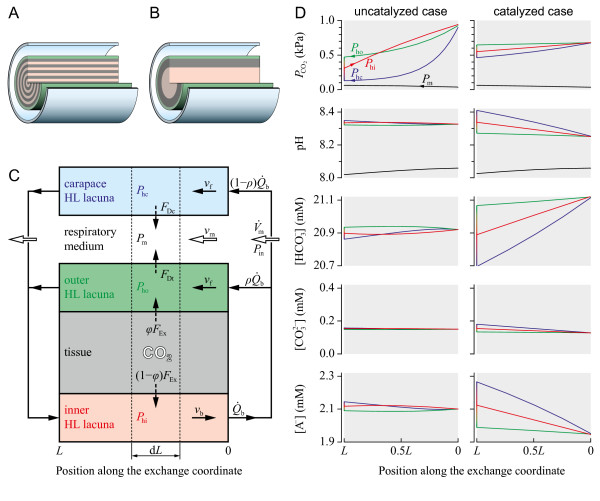
Modelling and simulation of CO2 transport. (A) Reference topology based on a cylinder-within-tubes arrangement (R. Moenickes, O. Richter and R. Pirow, in preparation). A sector piece was removed to show the alternation of concentric hollow cylinders of tissue (gray) and hemolymph (red, green, blue). (B) Simplified topology with only one tissue layer. This topology is applied in the compartment model. (C) Compartment model of the relevant transport processes. CO2 is excreted from the tissue compartment of length dL into the inner and outer hemolymph (HL) lacuna at rates of (1-φ)FEx and φFEx. Hemolymph leaving the inner HL lacuna at a volume-flow rate  is distributed between the outer HL lacuna and the carapace HL lacuna. From these compartments CO2 diffuses across cuticular barriers into the medium, which flows at a rate of . Indicated are the CO2 partial pressures (Phi, Pho, Phc, Pm) and flow velocities (νb, νf, νm) in the hemolymph lacunae and the medium. Pin is the inspiratory PCO2. (D) Simulation results for the uncatalyzed and catalyzed hydration of CO2 for an animal exposed to normal conditions (ambient pH = 8.0, ambient PCO2 = 0.035 kPa). Acid-base variables are shown for the medium and hemolymph lacunae in relation to the exchange coordinate.